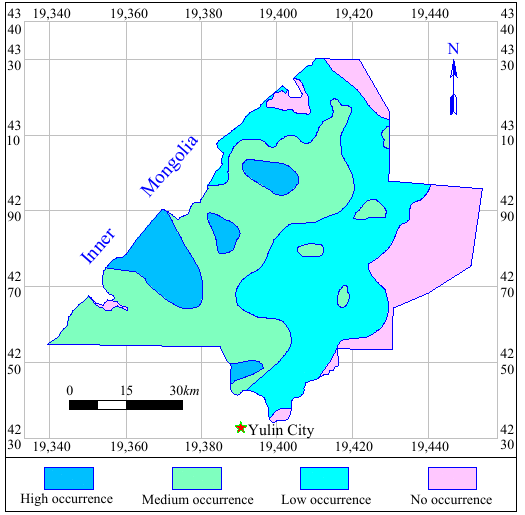
Figure 10. Zoning map of the water-richness of the overlying Salawusu Formation aquifer.